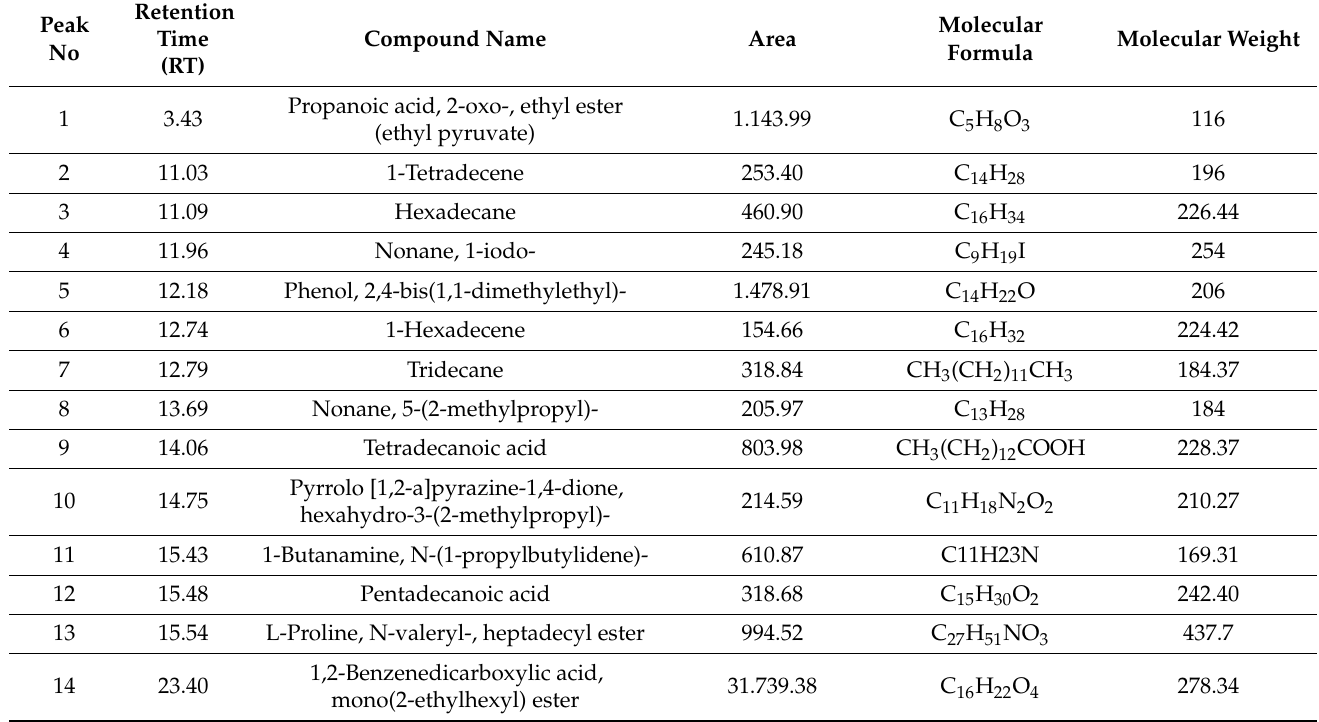
Table 3. The chemical properties of the 14 compounds of ethyl acetate extract of Paenibacillus polymyxa isolate SZYM culture filtrate using GC–MS